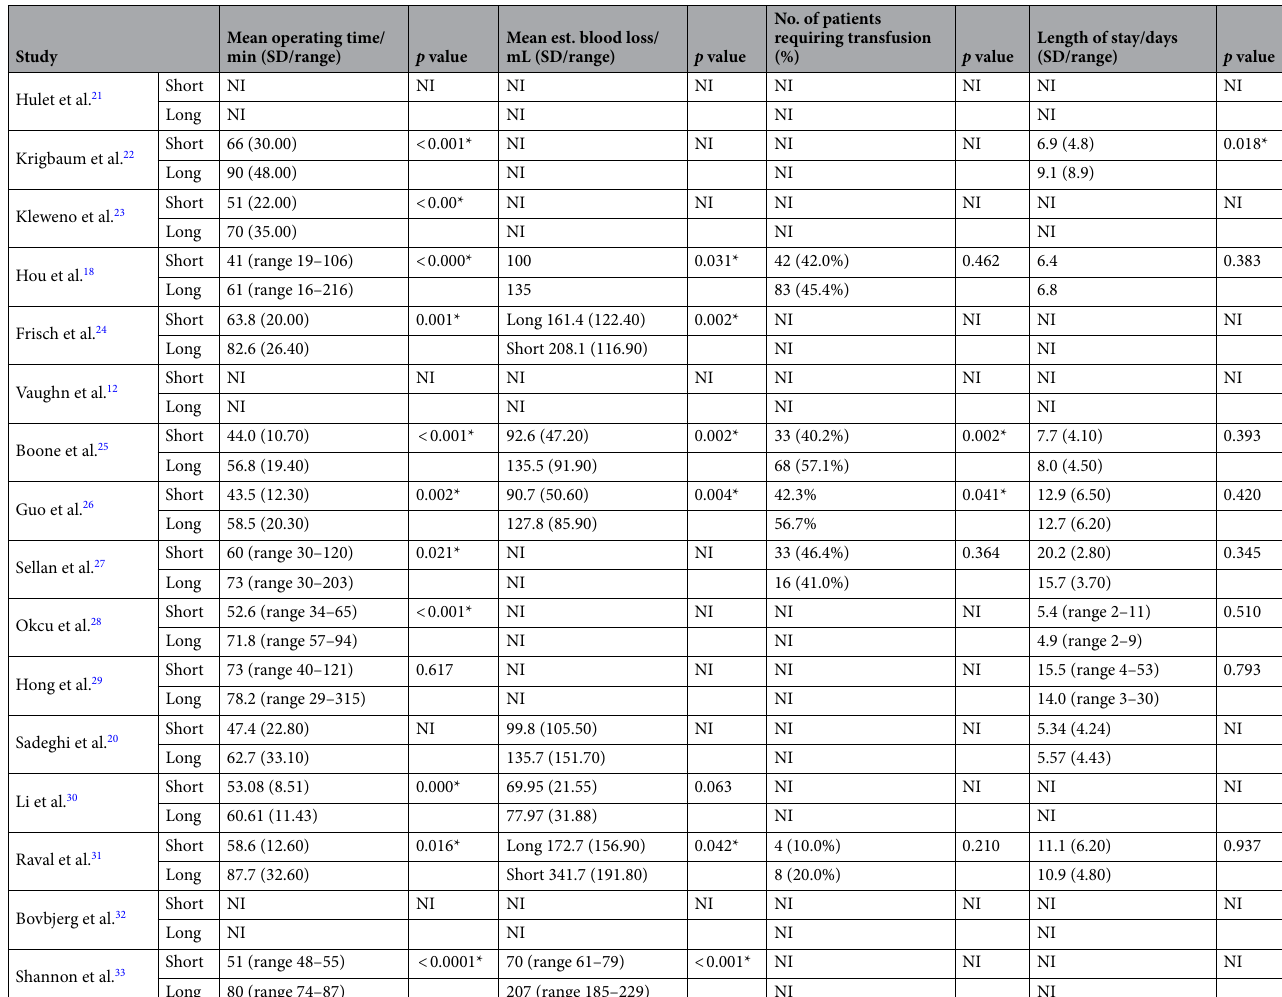
Table 2. Intra-operative results. NI no information. *Indicates statistically significant difference